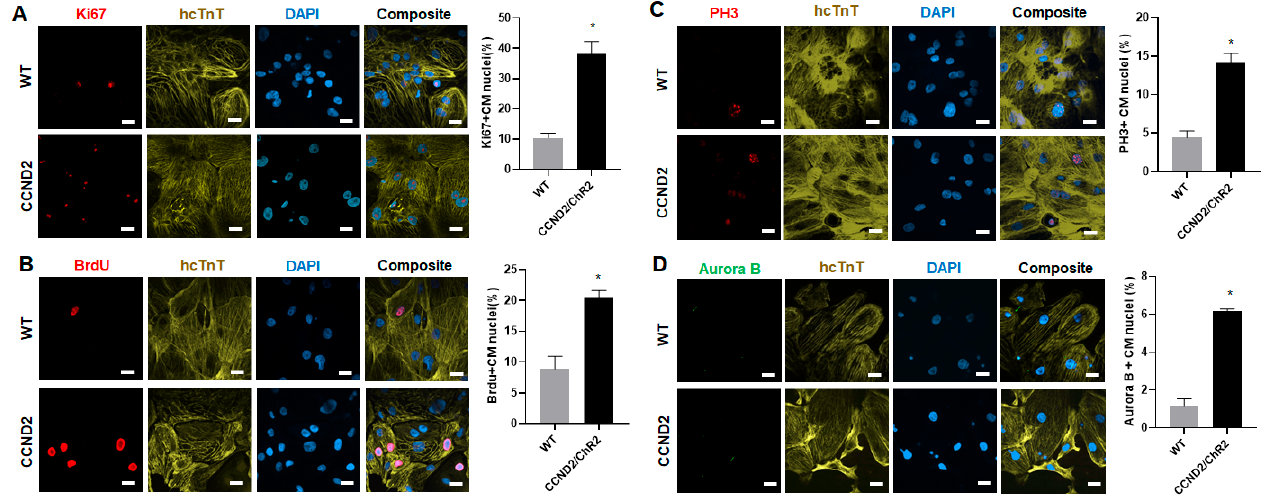
Figure 2. Quantification of cell cycle of CCND2 overexpressing hiPSC-CMs in vitro. The hiPSC- CCND2 WT CMs (WT) and hiPSC-CCND2 OE /ChR2 OE CMs (CCND2) were cultured for 4 weeks after the initiation of cardiomyocyte differentiation, and then immunofluorescently stained for the presence of human cTnT (hcTnT); nuclei were identified via DAPI staining. ( A ) Proliferation was evaluated via immunofluorescence analyses of Ki67 expression in hiPSC-CCND2 WT CMs and hiPSC- CCND2 OE /ChR2 OE CMs and quantified as the percentage of positively stained cells. Scale bar = 20 μ m. ( B ) S-phase cells were identified via immunofluorescence analyses of Brdu incorporation in hiPSC-CCND2 WT CMs and hiPSC-CCND2 OE /ChR2 OE CMs and quantified as the percentage of positively stained cells. Scale bar = 20 μ m. ( C ) M-phase cells were identified via analyses of PH3 expression and quantified as the percentage of positively stained cells. Scale bar = 20 μ m. ( D ) Cells undergoing cytokinesis were identified via Aurora B expression and quantified as the percentage of positively stained cells. Scale bar = 20 μ m. *— p < 0.05 versus hiPSC-CCND2 WT CMs by Student’s t-test. n = 6 repeats.